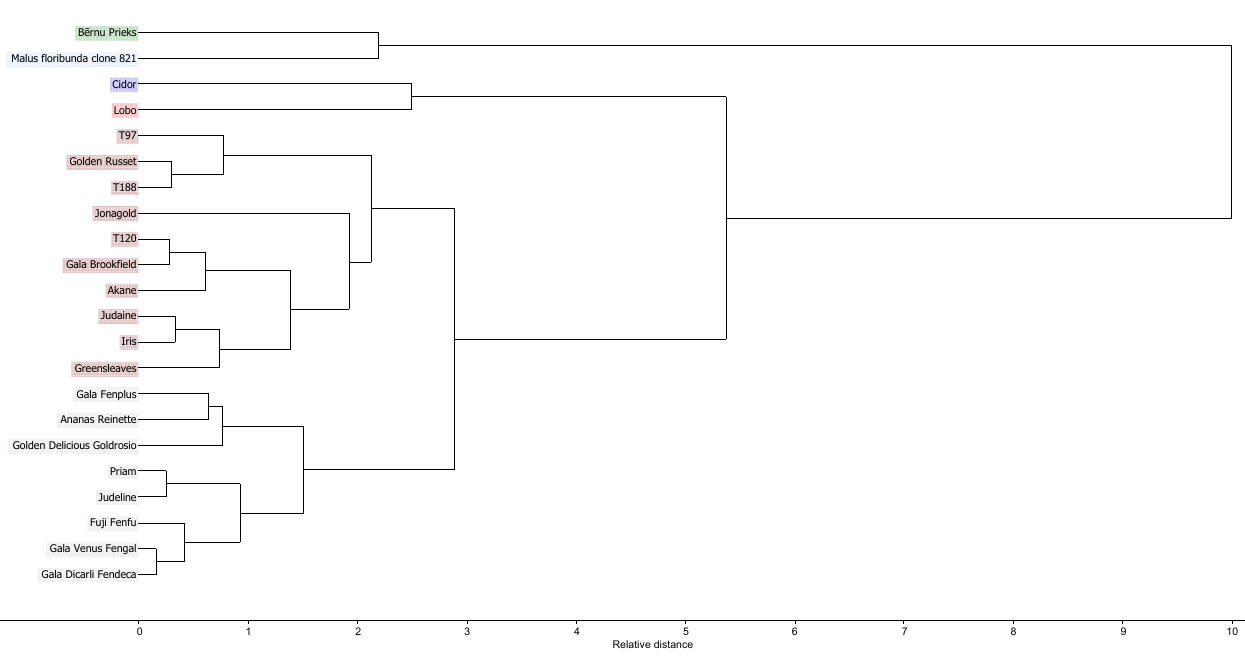
Figure 4. Hierarchical clustering diagram for the 22 studied apple genotypes.